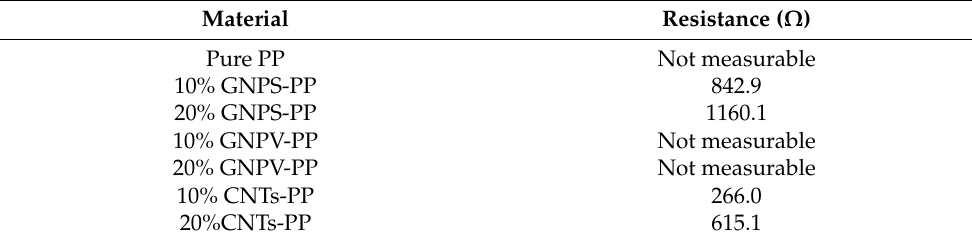
Table 1. Resistance measurements